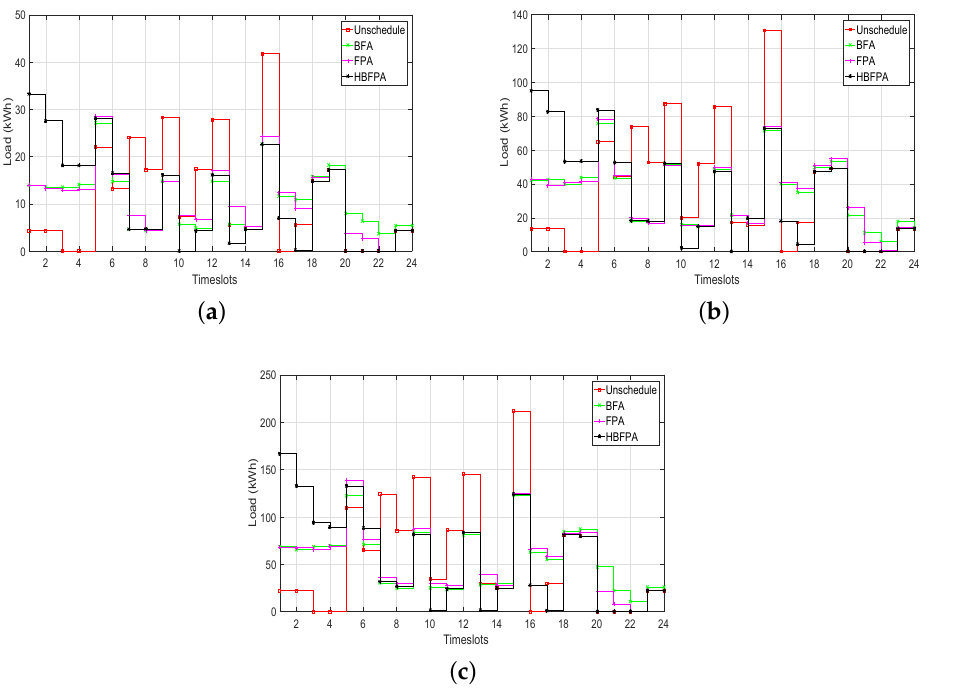
Figure 14. Load for multiple homes: (10, 30 and 50) using real time pricing. ( a ) load using operational time interval of 60 min for 10 homes; ( b ) load using operational time interval of 60 min for 30 homes; ( c ) load using operational time interval of 60 min for 50